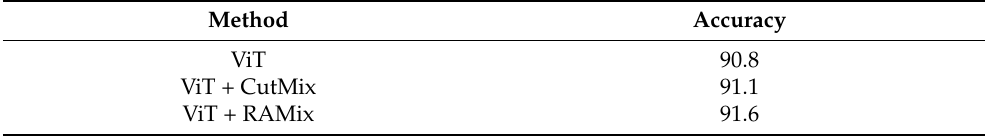
Table 4. Accuracy of different data augmentation methods.